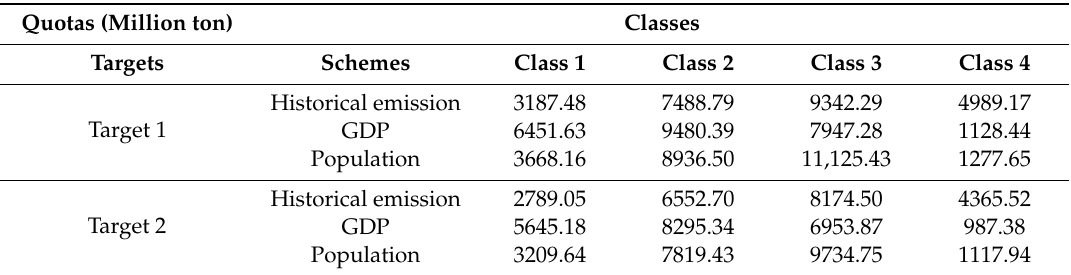
Table 6. The preferred scheme of each class according to three fundamental schemes.